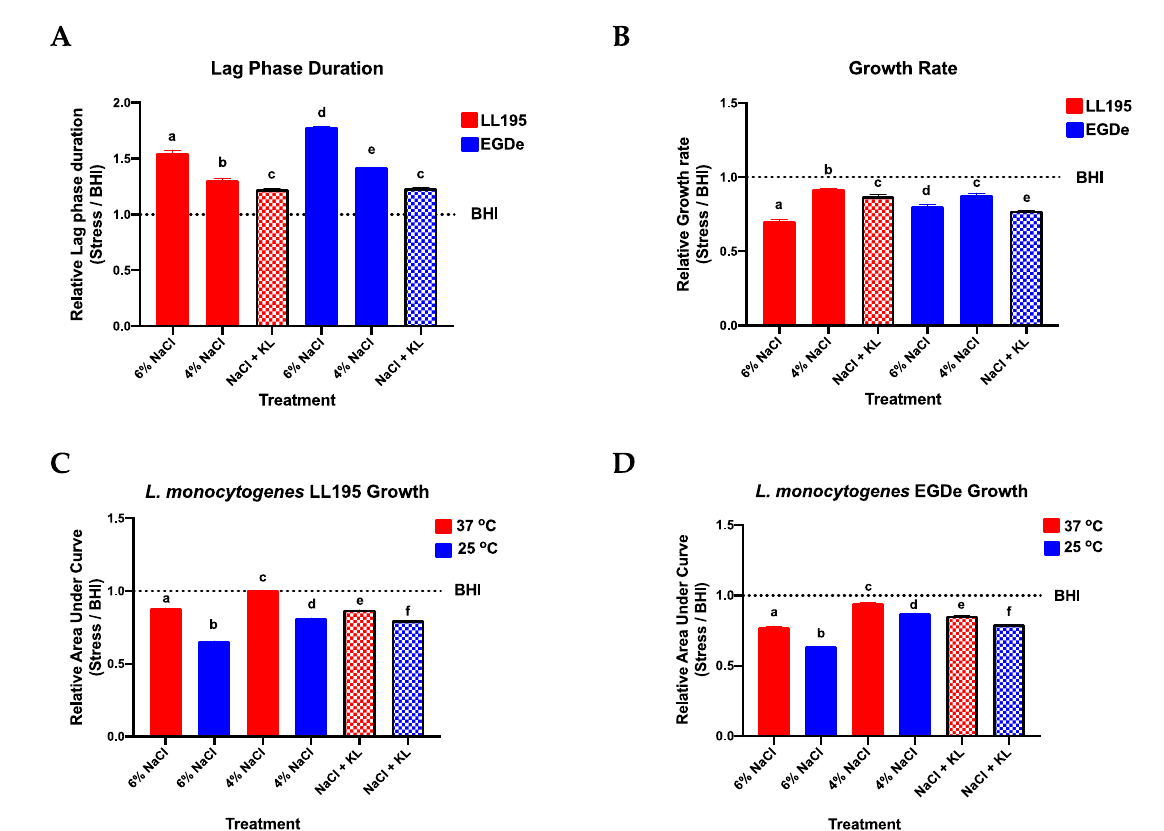
Figure 1. The low NaCl (2.8%) plus KL (1.6%) combination retains antimicrobial activity against L. monocytogenes (LL195 and EGDe) and temperature has a synergistic effect on the antimicrobial activity of both high NaCl (4% and 6%) concentration alone and the low NaCl plus KL combination (NaCl + KL). ( A , B ) At 37 °C L. monocytogenes lag phase durations were increased while growth rates were reduced through both interventions. ( C , D ) The application of high NaCl concentrations alone (4% and 6% NaCl) and the low NaCl plus KL combination (bars with patterns) both produced greater overall Listeria growth inhibition at lower (25 °C vs. 37 °C) temperature. Bars and error bars represent relative mean ( A ) lag phase duration ( B ) growth rate and ( C , D ) area under the curve generated using opm and GraphPad Prism from three replicates observed from kinetic growth assays in BHI supplemented with NaCl and KL at various concentrations and combinations. Each growth parameter per treatment presented are means expressed relative to those of the control with no stressor added. The control is represented by the dotted line labeled BHI. Different letters indicate a significant difference between strains ( p < 0.05 based on one-way ANOVA and Tukey post-hoc test pairwise comparison). Table 3. Comparison of L. monocytogenes EGDe and LL195 growth rates under osmotic stress a .